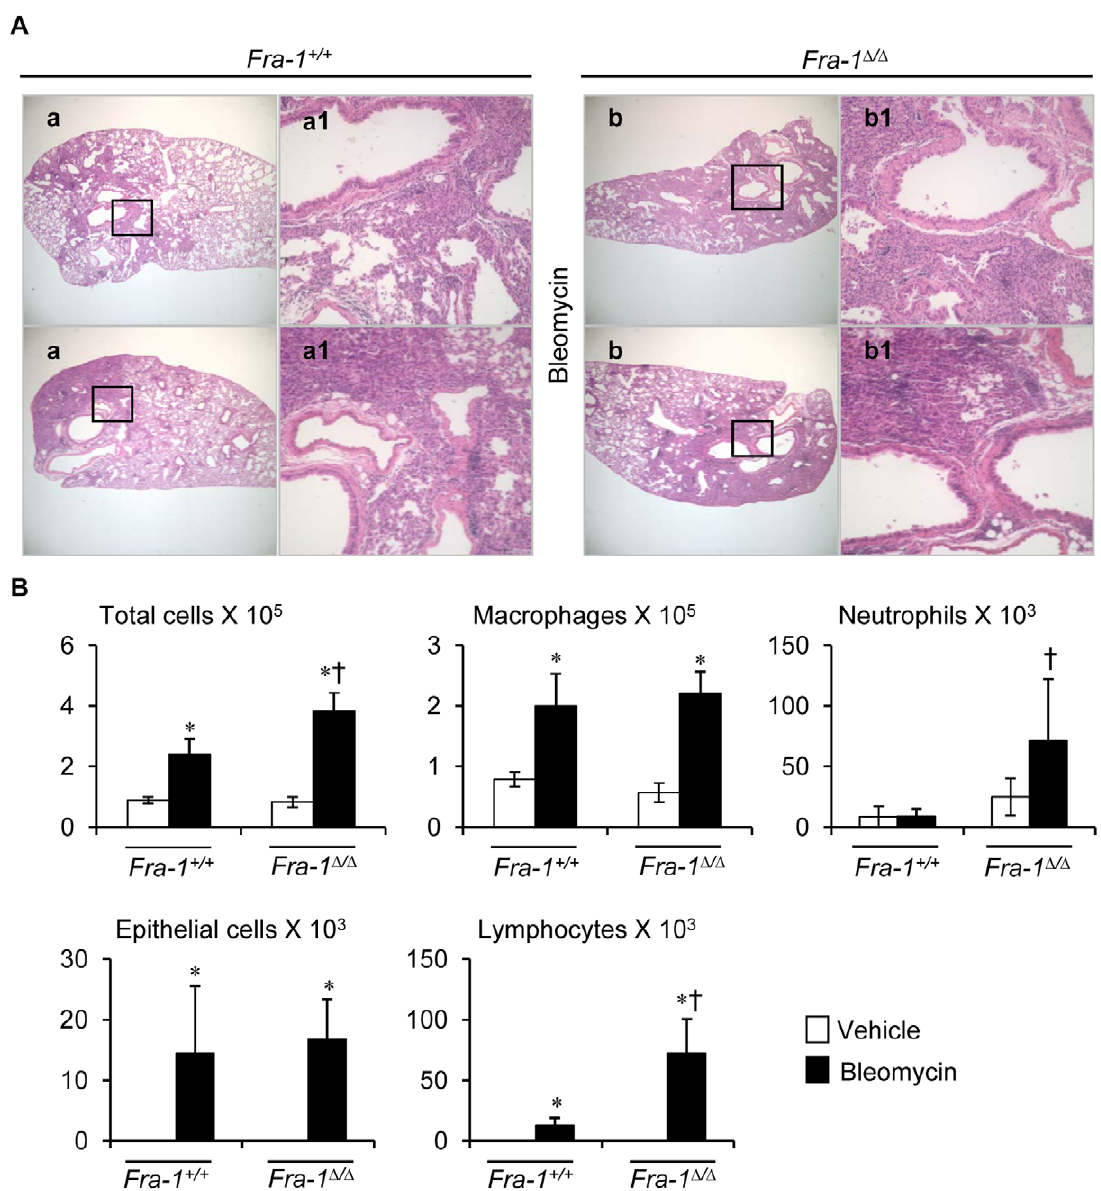
Figure 2. Fra-1 D / D mice show extensive pulmonary inflammation and fibrosis following 14 days post-bleomycin instillation. Mice (n=8 in each genotype) were intratracheally administered with bleomycin. Left lungs were fixed for histology (n=4) or used for mRNA analysis (n=4). Right lobes (n=8) were used for BAL cell and protein analysis. Representative results of two different experiments are shown. Samples obatined from mice treated with PBS were from Figure 3 (see below). A: Representative images of H&E stained lung tissue sections of bleomycin- treated Fra-1 + / + and Fra-1 D / D mice (n=4). B: Lung inflammatory cell profiles in BAL fluid of both genotypes (n=4). p , 0.05, PBS vs bleomycin; { p , 0.05, Fra-1 D / D vs Fra-1 + / + mice. Images a and b are at same magnification, 6 4; a1 and b1 are at 6 20 magnifications of a and b, respectively (boxed areas). doi:10.1371/journal.pone.0041611.g002 Fra-1 D / D mice treated with bleomycin for 31 days (Fig. 6A) when Col1A2 was significantly higher in bleomycin-treated Fra-1 D / D compared with their wild-type counterparts. In contrast, the mice than in Fra-1 + / + mice at 31 days (Fig. 5C). Immunoblot expression level of MMP-13 was unaltered between two genotypes analysis using antibodies specific for Col1 revealed enhanced levels after bleomycin treatment (Fig. 6A). The expression levels of the of Col1 in Fra-1 D / D mice treated with bleomycin when compared gelatinase MMP-2 and of the metalloelastase ( MMP-12 ) were with their corresponding vehicle control and Fra-1 + / + counterparts significantly different between the Fra-1 D / D and Fra-1 + / + mice (Fig. 5D). The accumulation of collagen depends not only on its production, but also on its degradation. Hence, we next analyzed subjected to 31 days of bleomycin. MMP-2 expression was the expression patterns of collagenases ( MMP-1 b and MMP-13 ), markedly up-regulated in Fra-1 D / D mice when compared with Fra-1 + / + mice. Although bleomycin-induced MMP-12 expression metalloelastase ( MMP-12 ), and gelatinases ( MMP-2 ). There was a significant reduction in MMP-1 b transcript levels in the lungs of was higher in the lungs of Fra-1 D / D mice than Fra-1 + / + mice, no